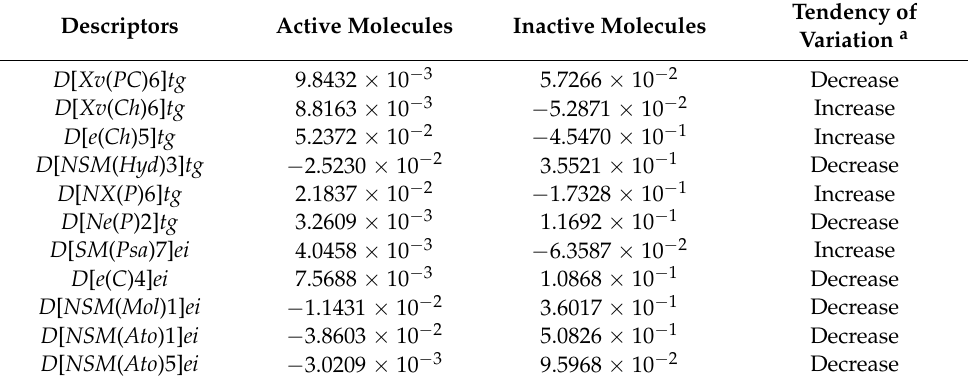
Table 3. The D [ GTI ] cj descriptors and their tendencies of